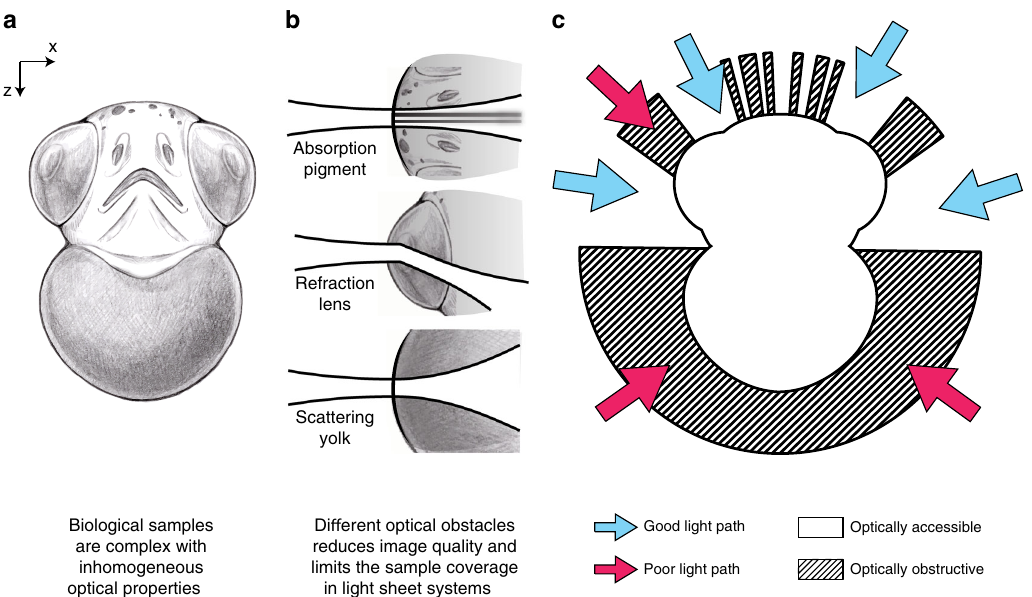
Fig. 1 Illustrations of common artefacts in optical microscopy. a Frontal view onto a schematic of a zebra fi sh embryo along the anterior-posterior axis. b Illustration of different optical obstructions in the sample and potential effects on incident excitation light. c Illustration showing how the optical obstructions result in predictable quality differences between optical